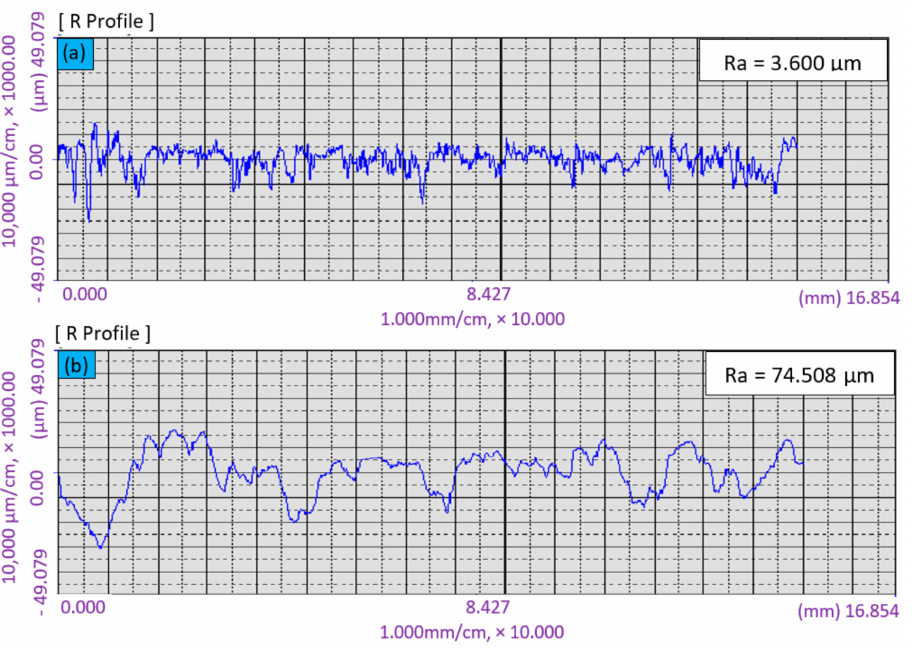
Figure 10. Roughness profiles of substrate: ( a ) left as-cast surface; ( b ) wire brush.